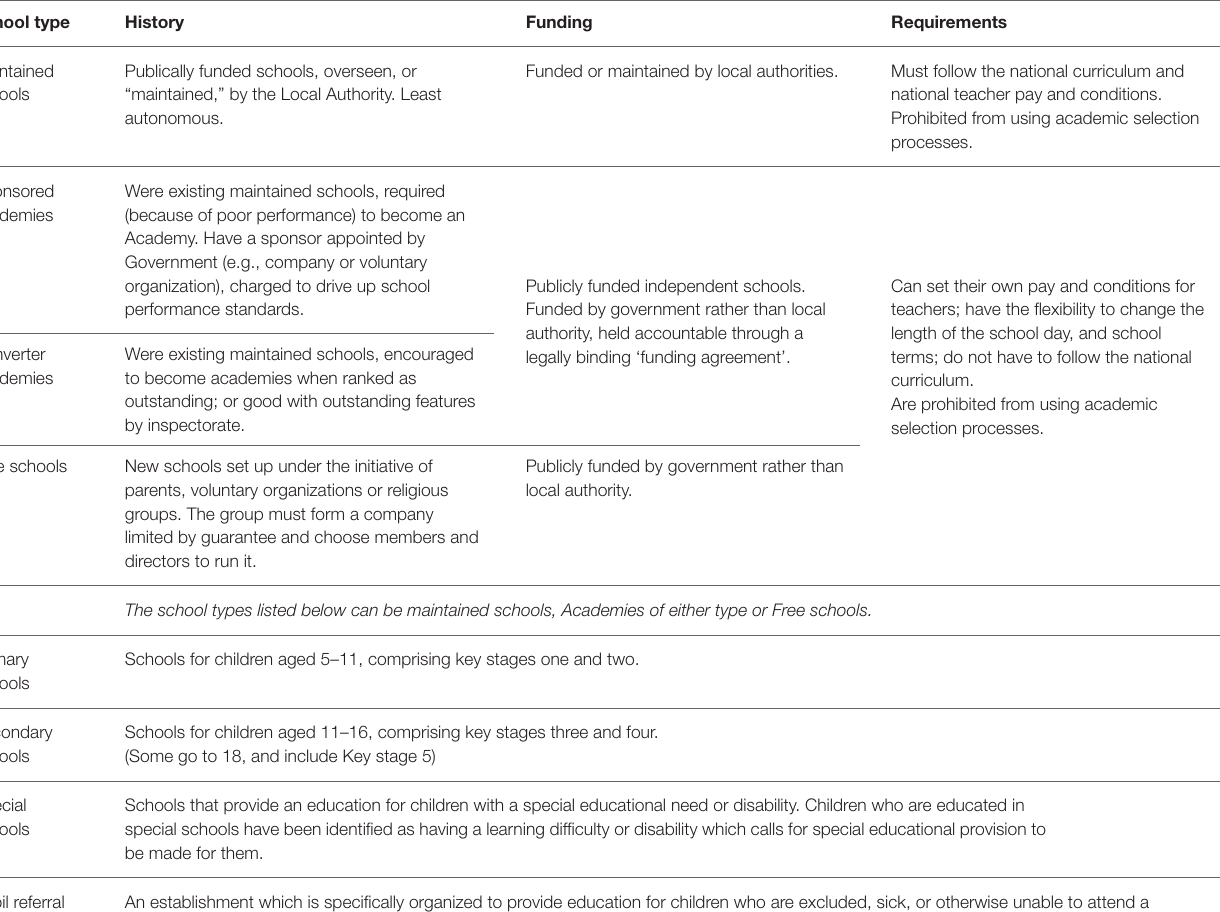
TABLE 1 | Type of educational